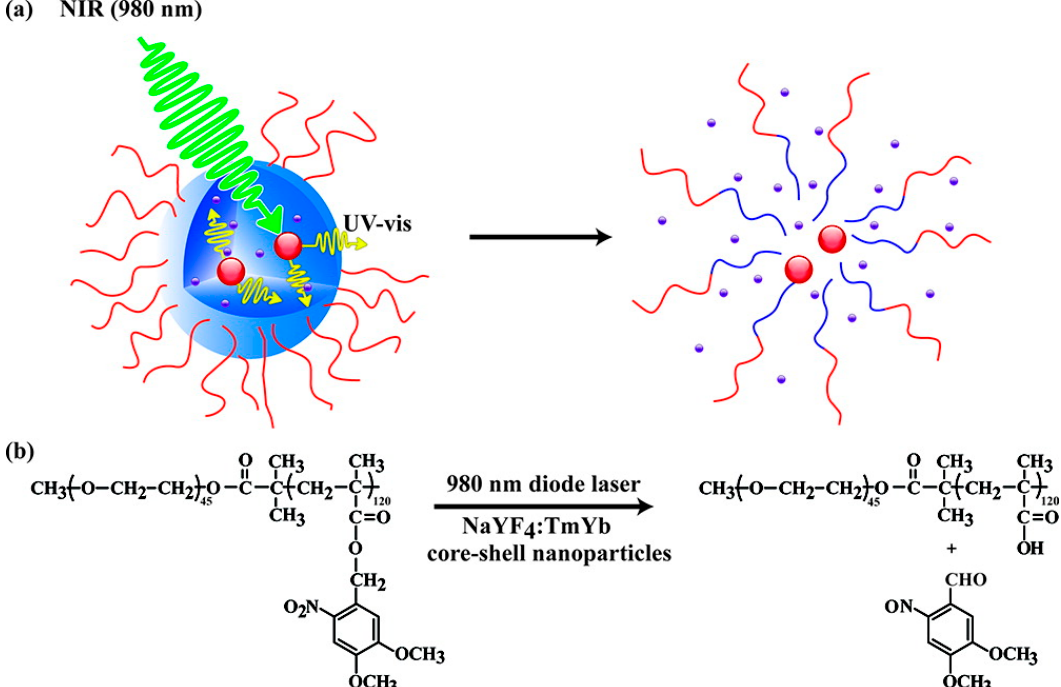
Figure 6. ( a ) Schematic illustration of using NIR light excitation of UCNPs to trigger dissociation of BCP micelles. ( b ) NIR light-triggered photoreaction with the used BCP of PEO-b-PNBMA and UCNPs of NaYF4:TmYb. Reproduced from ref. [150] with permission from the American Chemical Society.